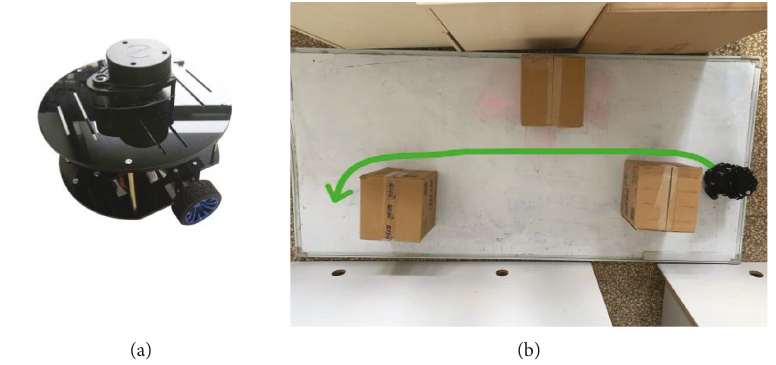
Figure 22: Experimental scenario. (a) ROS trolley. (b) Dormitory hallway environment.